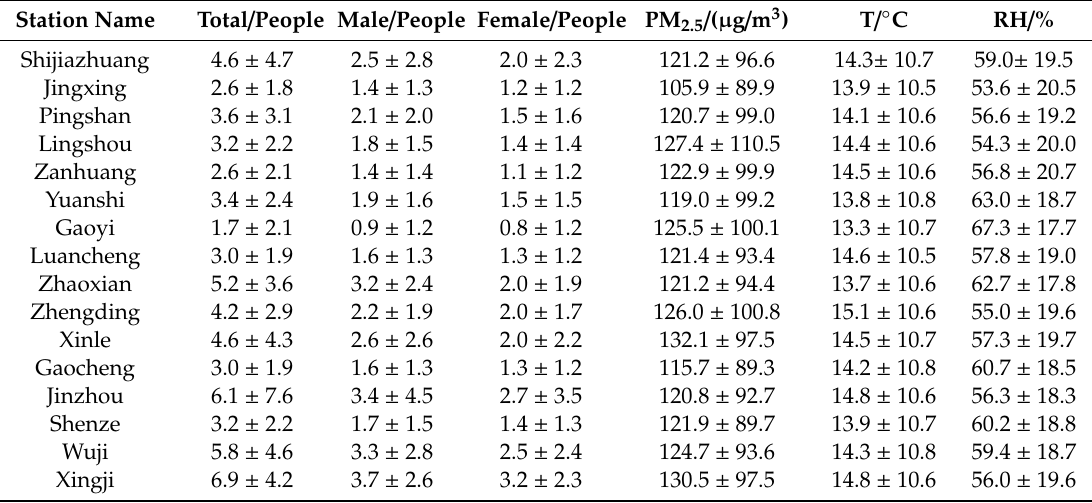
Table 1. Statistical characteristics of the circulatory system deaths, PM 2.5 concentration (particulate matter with a diameter equal or lower than 2.5 micrometers) and meteorological factors from 2014 to 2016 (mean ± standard deviation). RH: relative humidity.